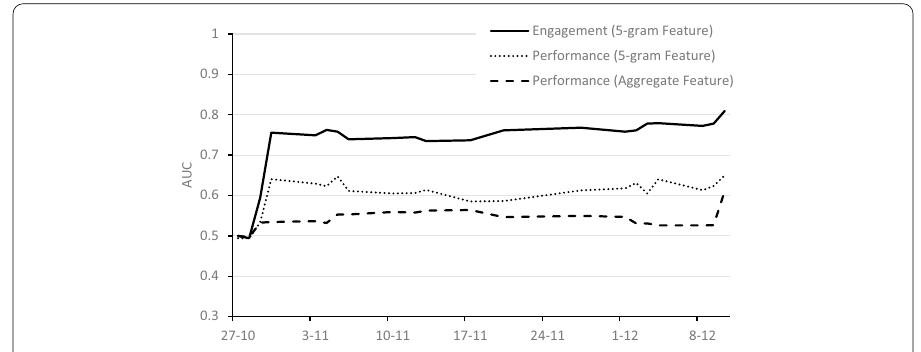
Fig. 7 Evaluation by AUC over time of early warning prediction of learner engagement and performance in the open-book